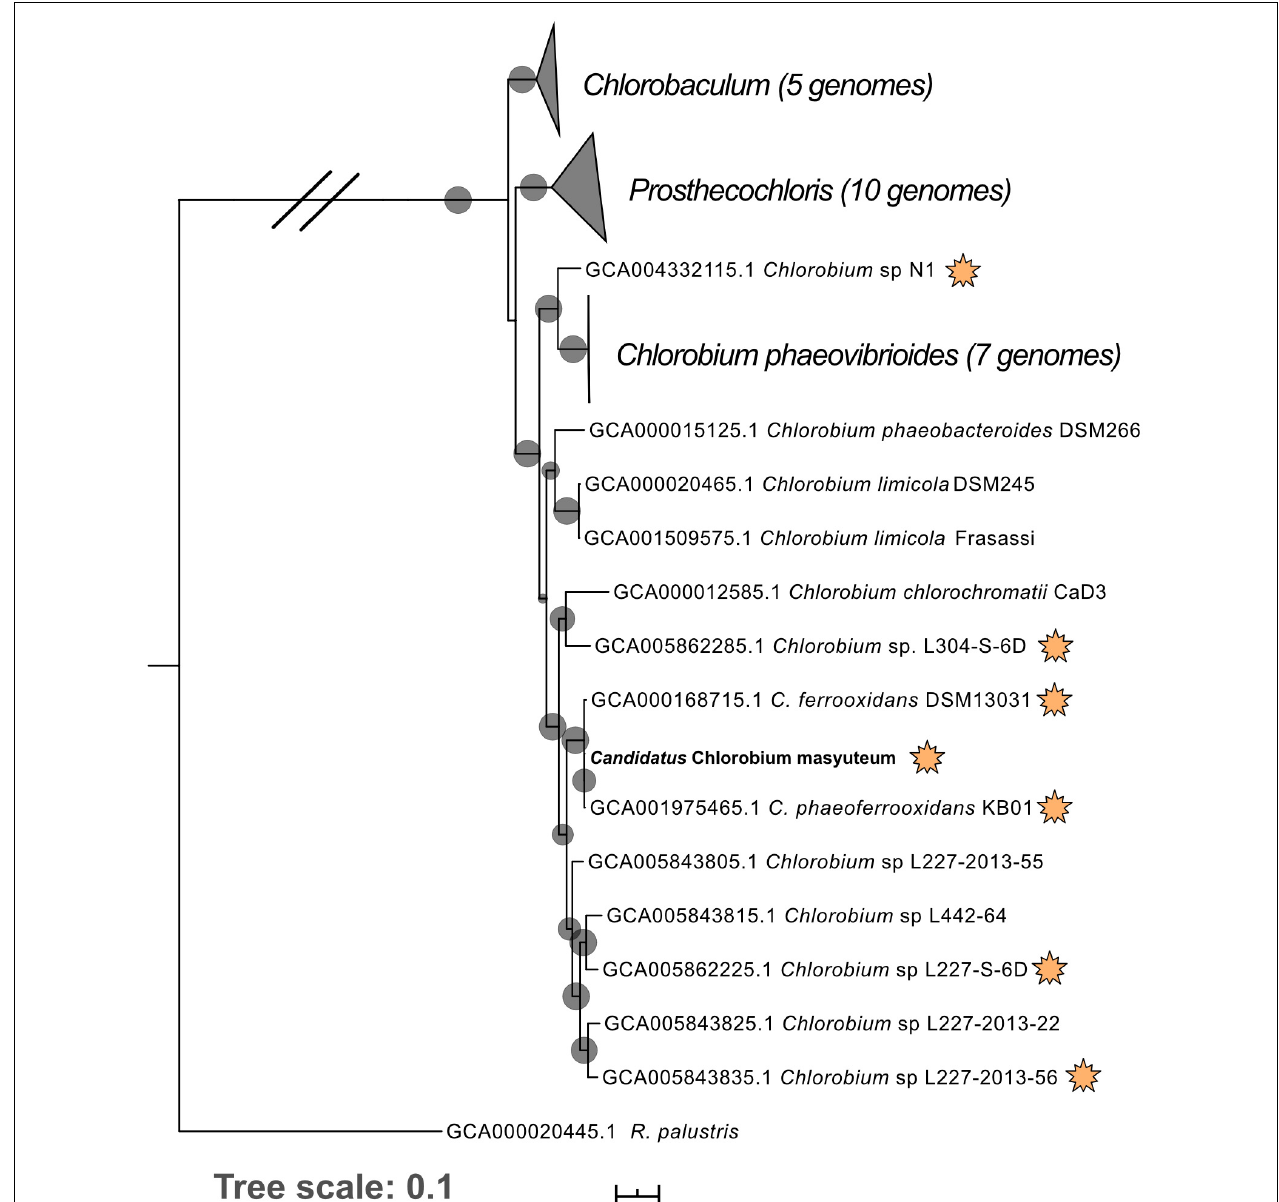
FIGURE 1 | Phylogenomic tree of “ Ca . C. masyuteum” with other Chlorobia isolates and metagenome assembled genomes. Genomes highlighted with orange stars are either experimentally verified or inferred from the genome to photo-oxidize Fe(II). Bootstrap values ( > 75%) are represented by black circles. Orange stars represent organisms with either tested or inferred photoferrotrophy